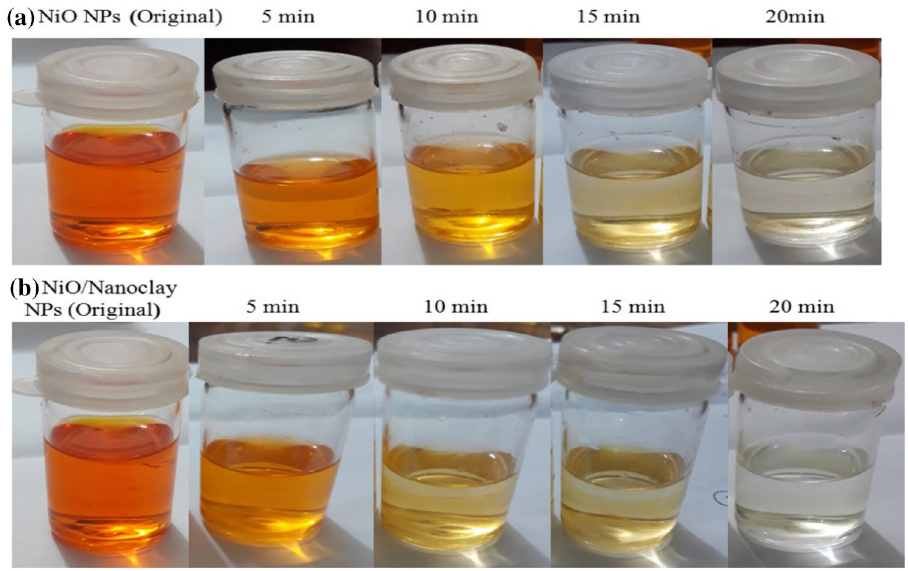
Fig. 6 Digital photograph of O II dye before and after degrada- tion reaction under UV-light photodegraded by a NiO NPs and b NiO/Nc